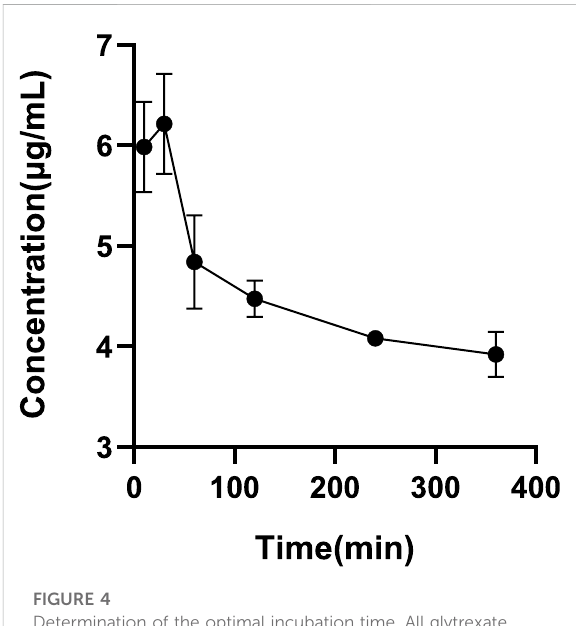
FIGURE 4 Determination of the optimal incubation time. All glytrexate values are listed as the mean value ± SD. Bars represent